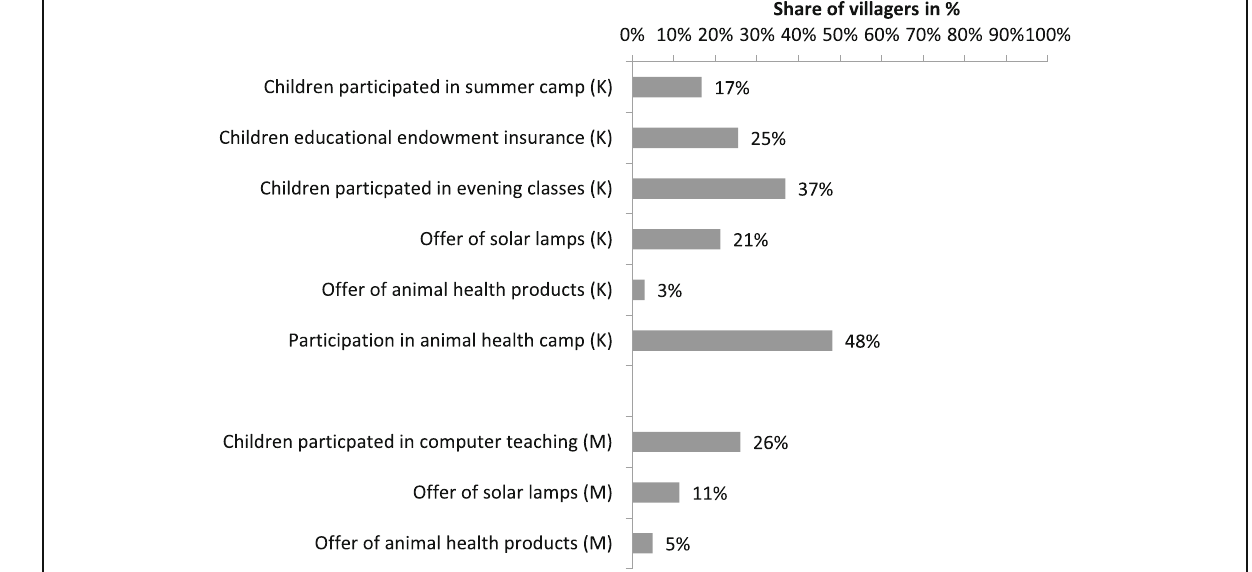
Fig. 3 MVP participation in further Bayer Crop Science ‘ s activities. Source: MVP Panel Survey, 2nd wave 2014, own calculations. K = Kadivala, M =